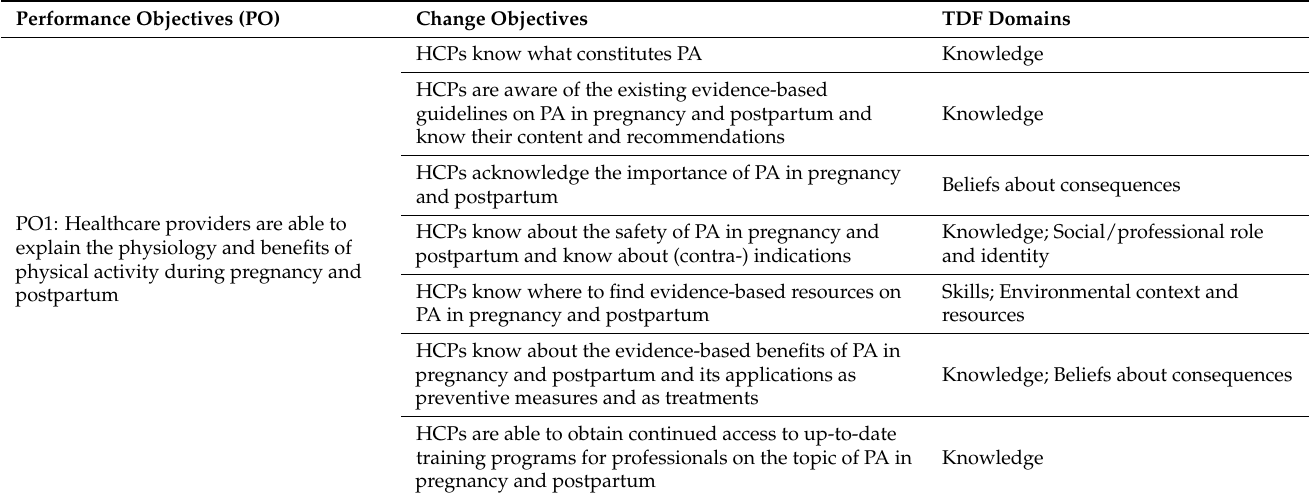
Table 2. Performance objectives with mapped change objectives and respective TDF domains. Performance Objectives